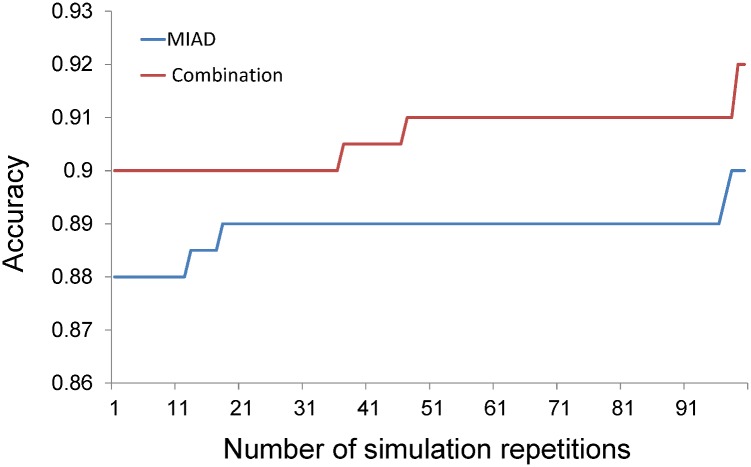
Bootstrap sampling method for comparing the stage II parameter combination versus the MIAD alone.Comparison of the combination method and the MIAD alone by sampling 100 cases and simulating 100 repetitions to obtain the median of accuracy and plot the line chart (if the sampling data have a Gaussian distribution, then the median can be replaced by the mean; thus, t = 42.57 and p < 10−64). MIAD, minimal axial diameter; MAAD, maximal axial diameter; MACD, maximal coronal diameter; NSUVmean, nodal mean standard uptake value.